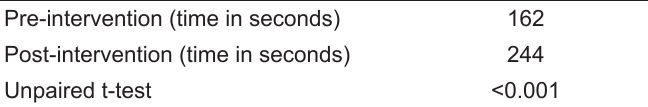
Differences between pre and post-intervention were analyzed using the unpaired